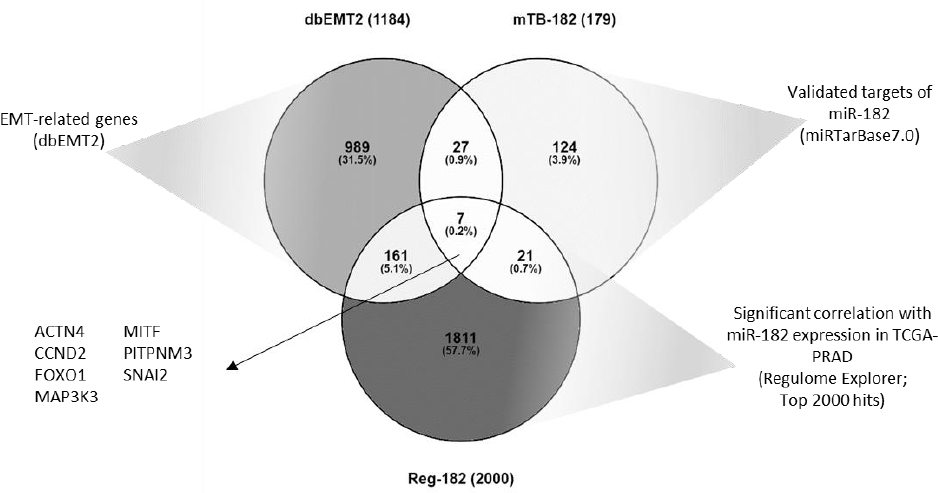
Figure 4. Seven genes common to datasets from dbEMT2, miRTarBase7.0, and Regulome Explorer TCGA-PRAD databases were identified as potential targets of miR-182.